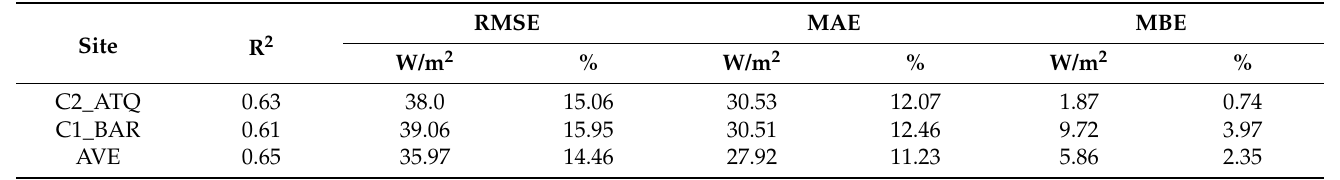
Table 5. R 2 , RMSE, MAE, and MBE of ISCCP-FD DLR at sites within one ISCCP-FD Grid.